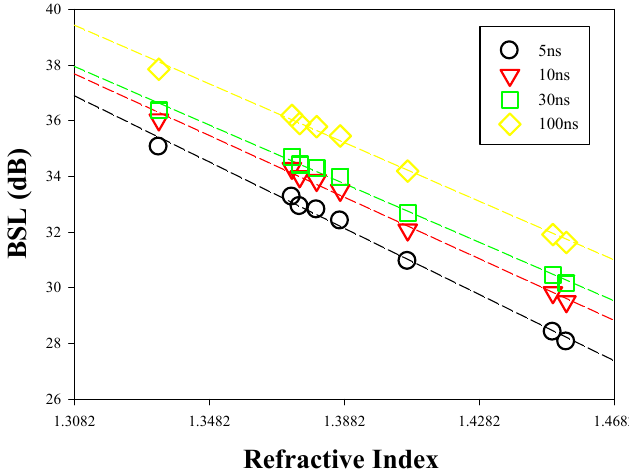
Figure 5. BLS levels from the OTDR traces under various testing liquid chemicals at 1,100 m SMF long, when the 1,550 nm pulse laser is setup at 5, 10, 30 and 100 ns,